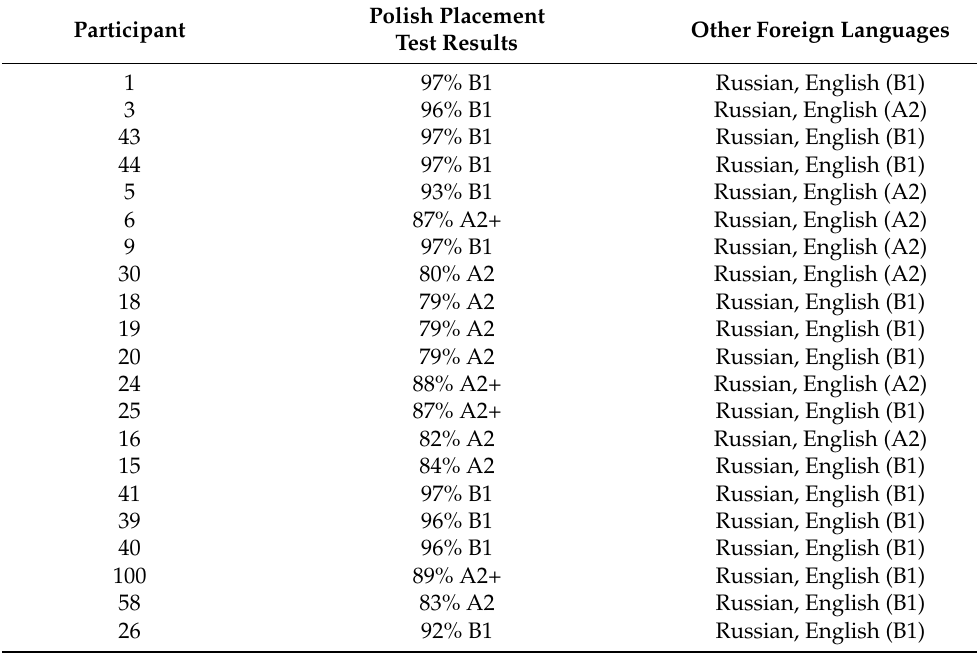
Table A4. Foreign language knowledge (L3 Polish based on placement test results, Russian proficiency based on BLP and other foreign language proficiency is